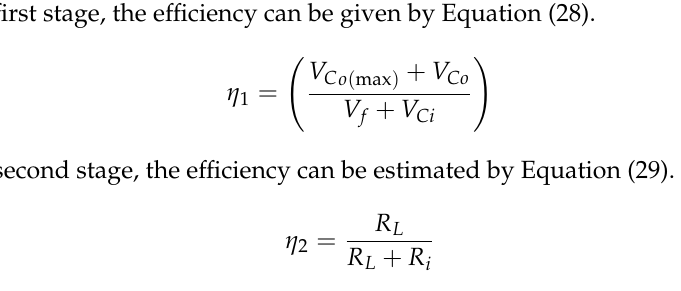
Figure 25. Waveforms representing a capacitor discharging into a parallel RC circuit. In the first stage, the efficiency can be given by Equation